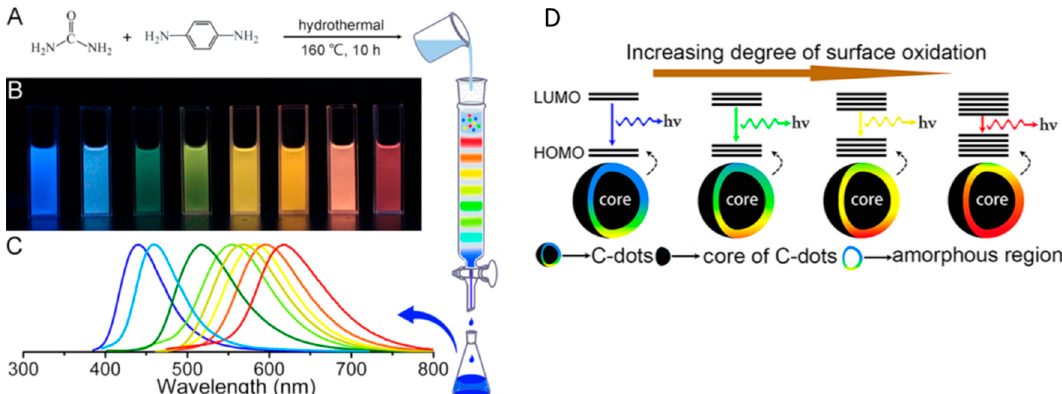
Figure 5. ( A ) One-pot synthesis and purification route for CDs with distinct photoluminescence (PL) characteristics, ( B ) eight CD samples under 365 nm UV light, ( C ) corresponding PL emission spectra, and ( D ) model for the tunable PL of CDs with different degrees of oxidation: reprinted with permission from [70], copyright 2016 American chemical society.